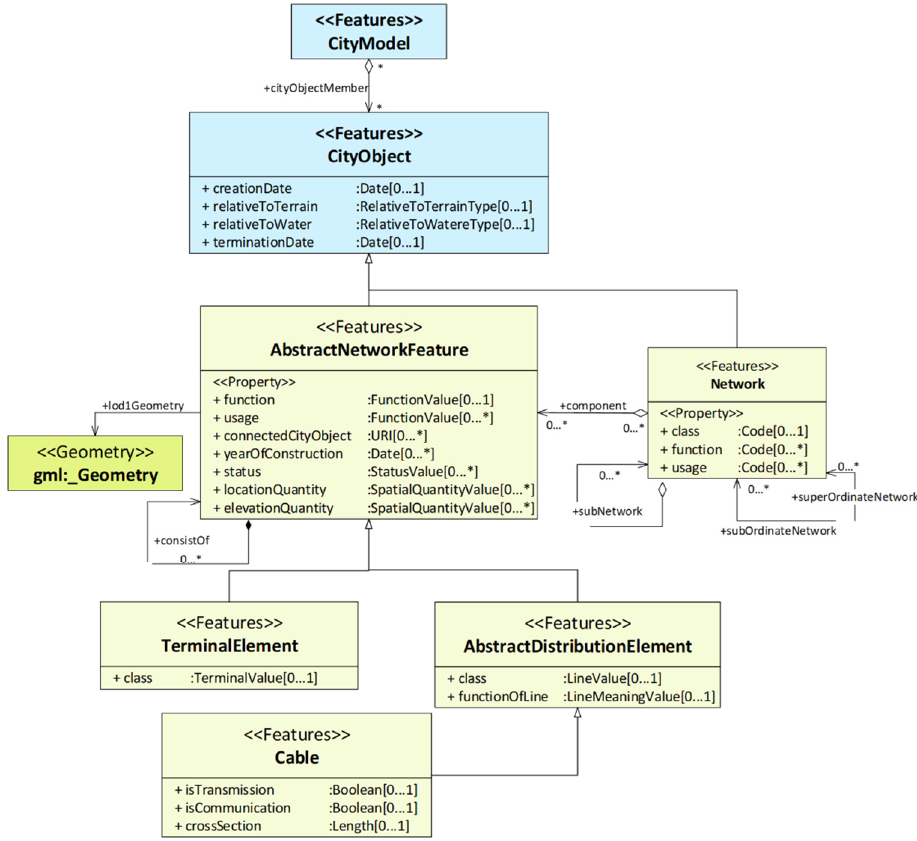
Figure 6. UML class diagram showing employment of the CityGML utility network core module for the electricity